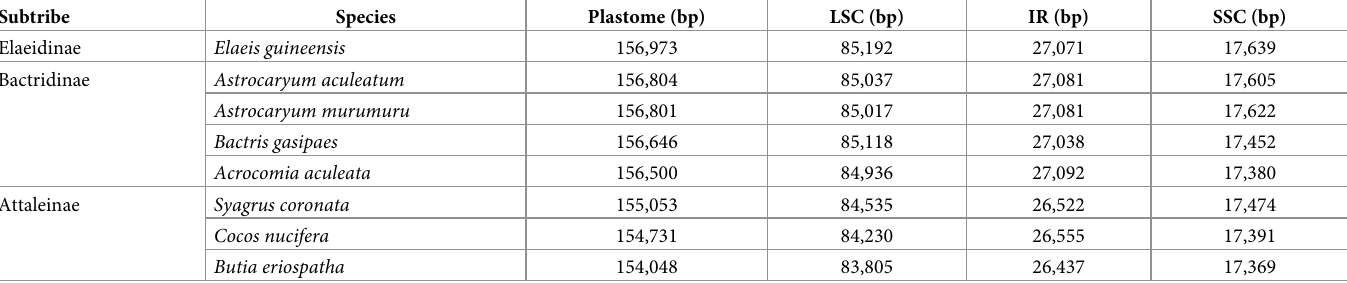
LSC: large single copy region; IR: inverted repeat; SSC: small single copy